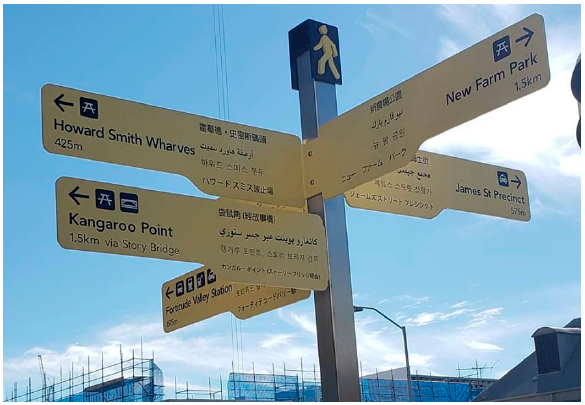
Figure 18. A street signpost in Brisbane, Australia. Photograph taken and permission granted by Altizer.